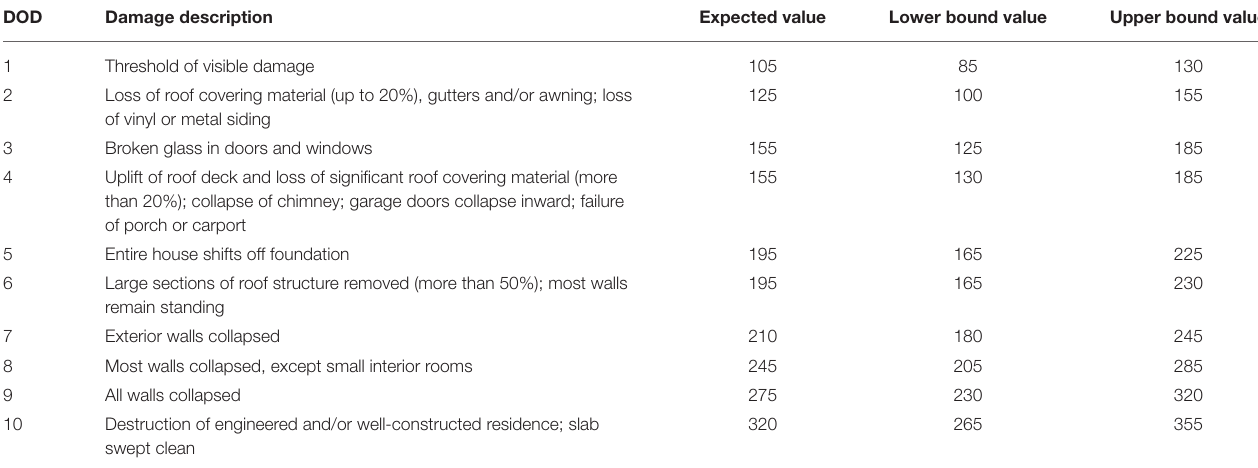
TABLE 1 | EF-Scale DOD Descriptions and Wind Speeds in km/h for FR12 (Environment Canada,